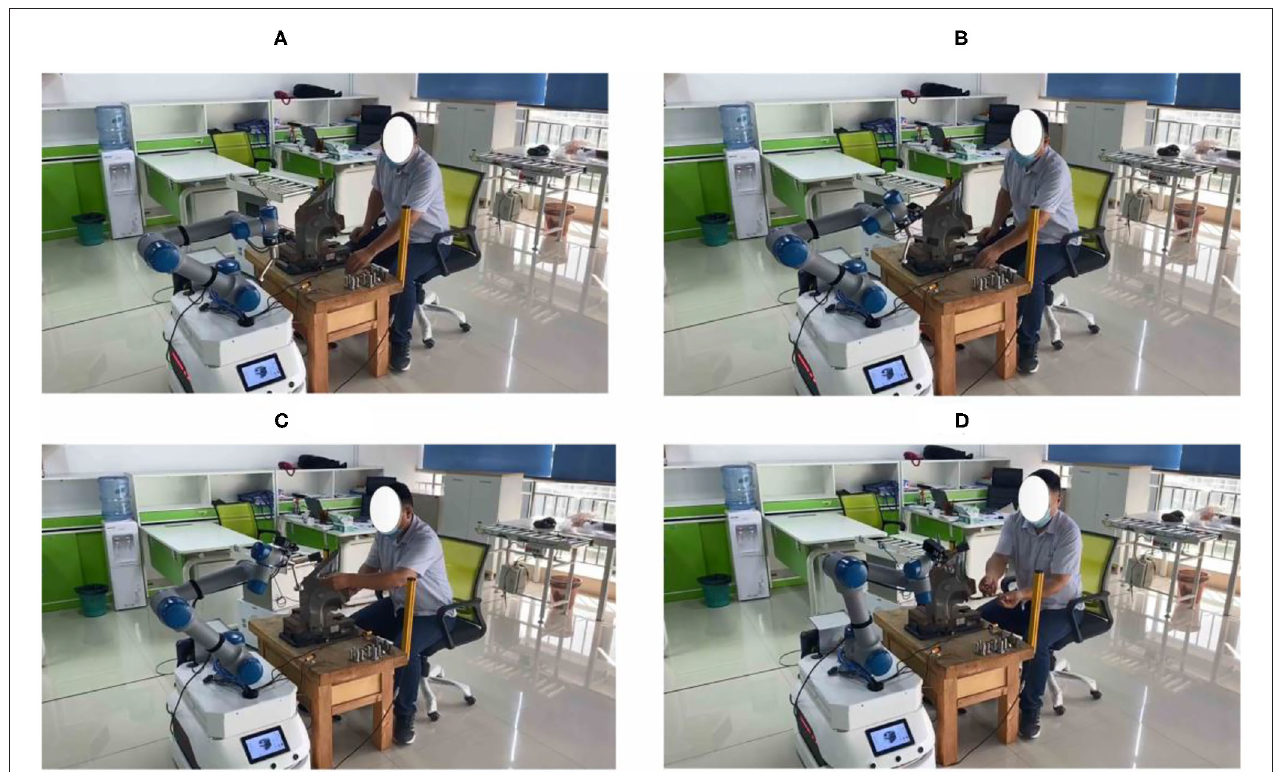
FIGURE 10 | Human operation intention recognition. (A) Indicates that the robot reads the instruction and starts. (B) Means to understand the intention of the operator. (C) Indicates the selection of qualified workpiece. (D) Represents collaborative